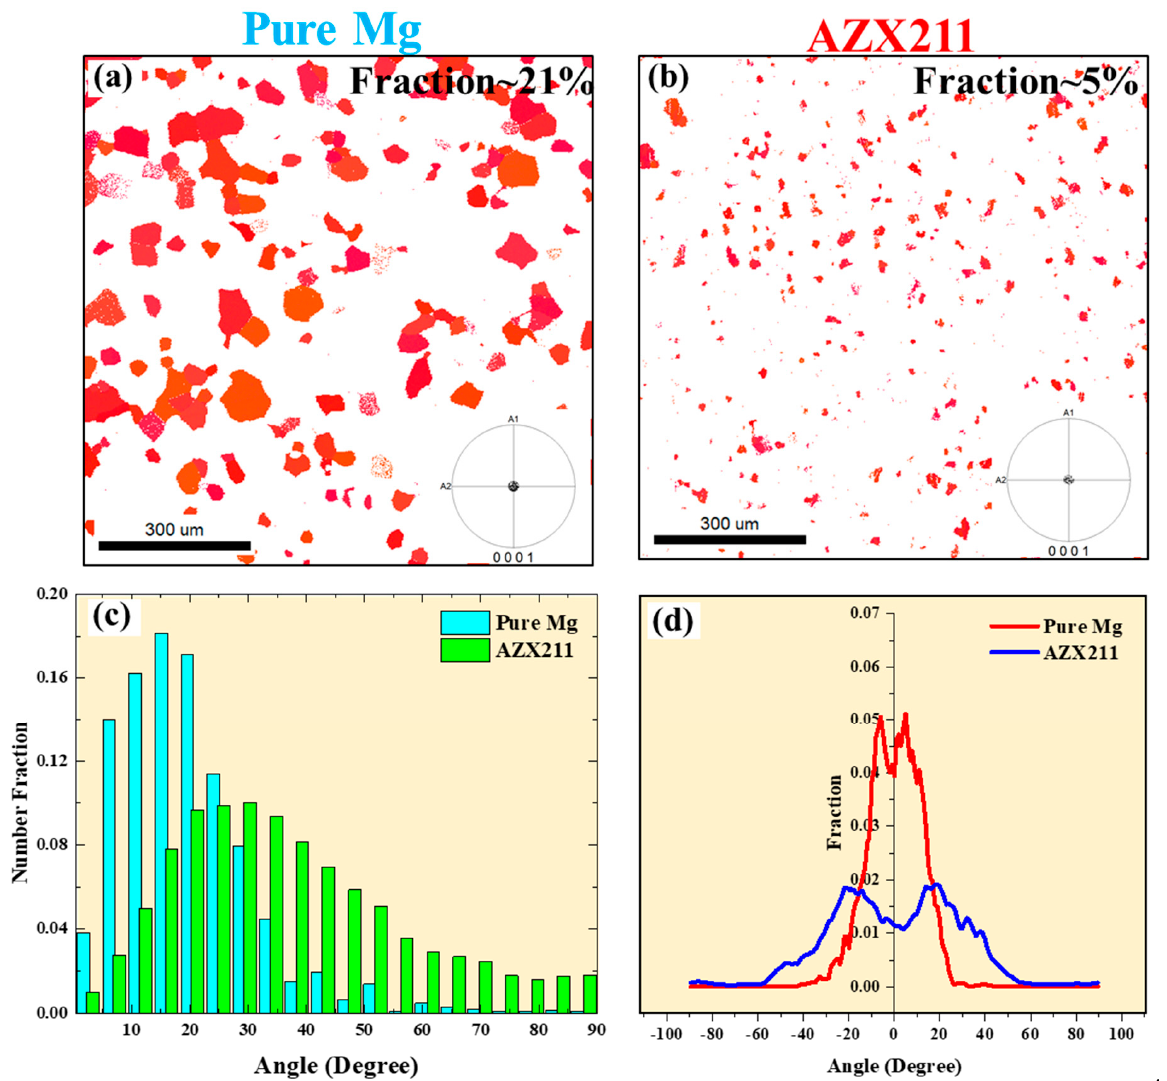
Figure 5. Partitioned IPF maps for basal-oriented grains in ( a ) pure Mg, ( b ) AZX211, ( c ) crystal direction and ( d ) pseudo rocking curves for both the samples.